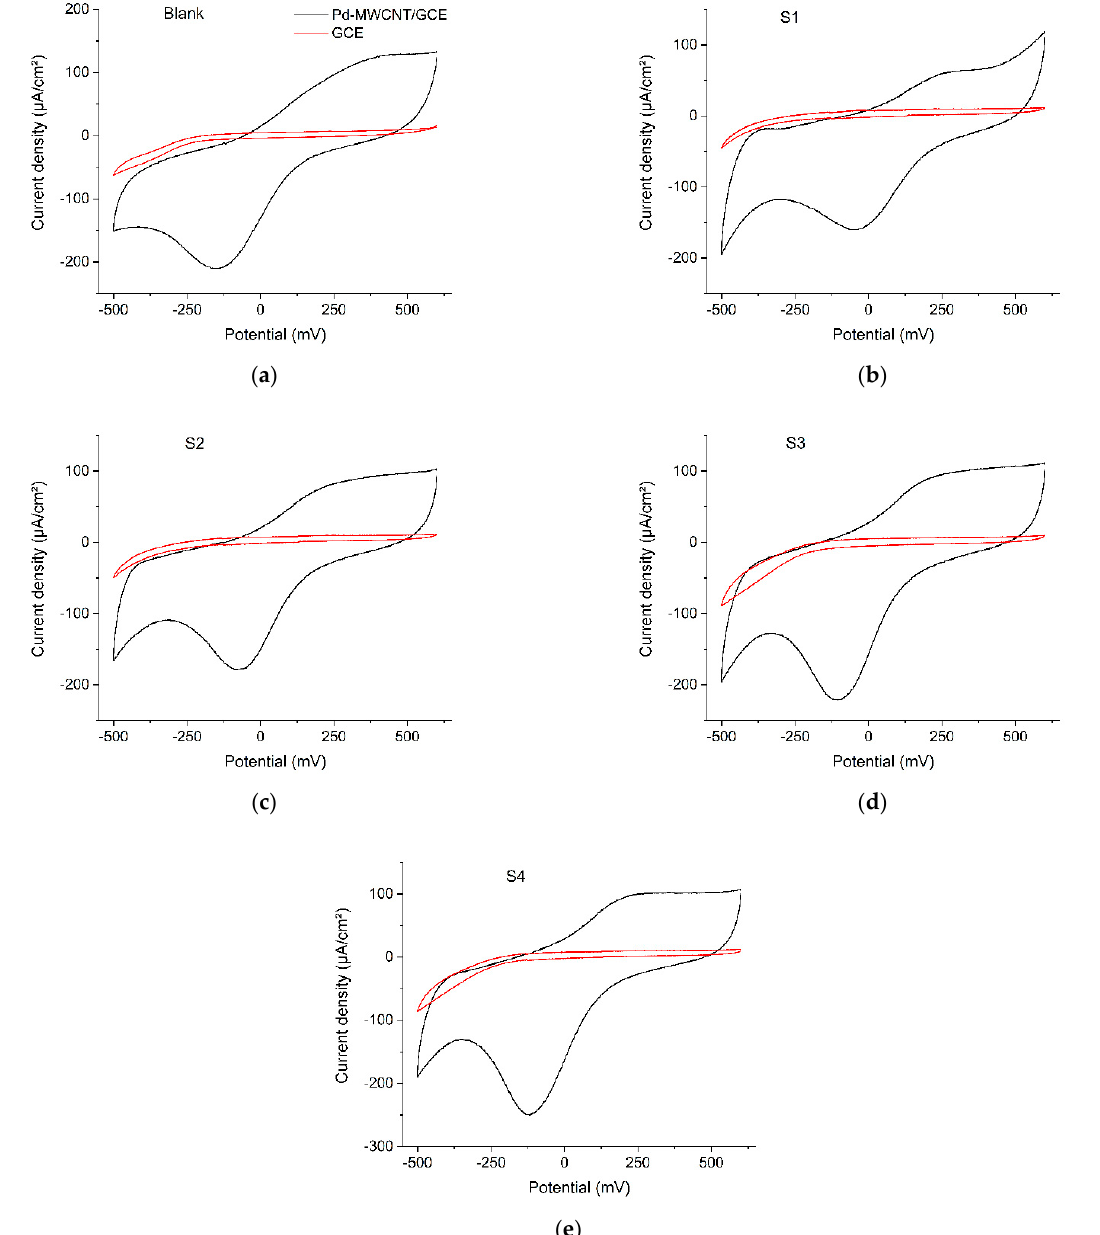
Figure 1. Cyclic voltammetry of the unmodified GCE (red line) and the Pd/MWCNT/GCE (black line) in the deuterated aqueous solutions ( a ) 25 ppm, ( b ) 1120 ppm, ( c ) 2100 ppm, ( d ) 5030 ppm and ( e ) 9880 ppm, at a scan rate of 50 mV/s, vs. the Ag/AgCl 3 M KCl. This indicates that one electron, corresponding to the 1 H atom, is transferred in the rate determining step and that the other electron, corresponding to the other hydrogen atom, is transferred during a diffusion-controlled process.